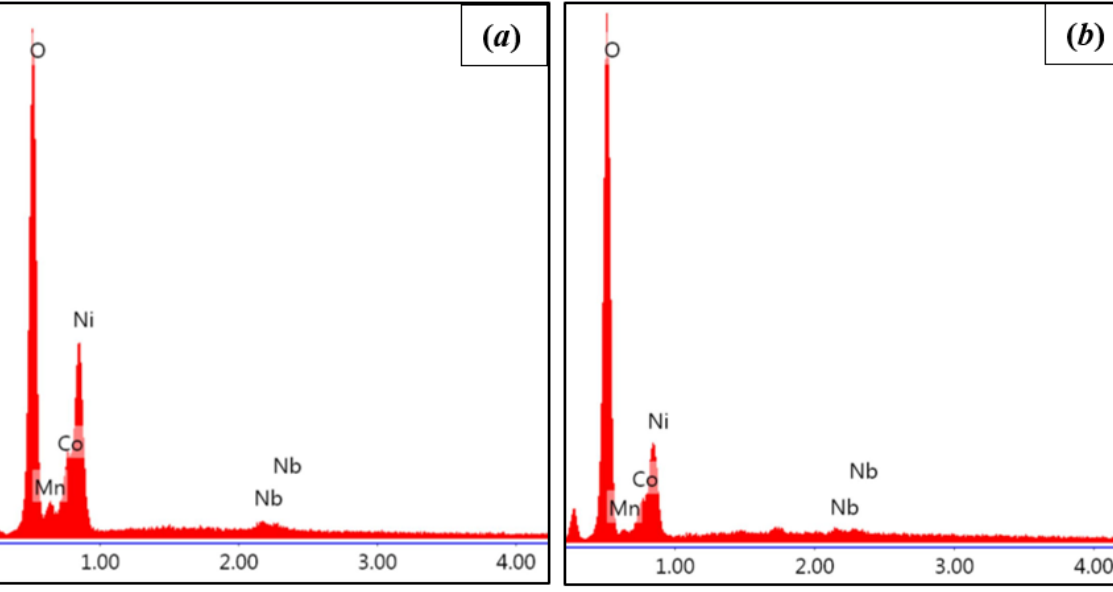
Figure 7. EDX analysis of 1% LNO coating using ( a ) Method-I and ( b ) Method-II.